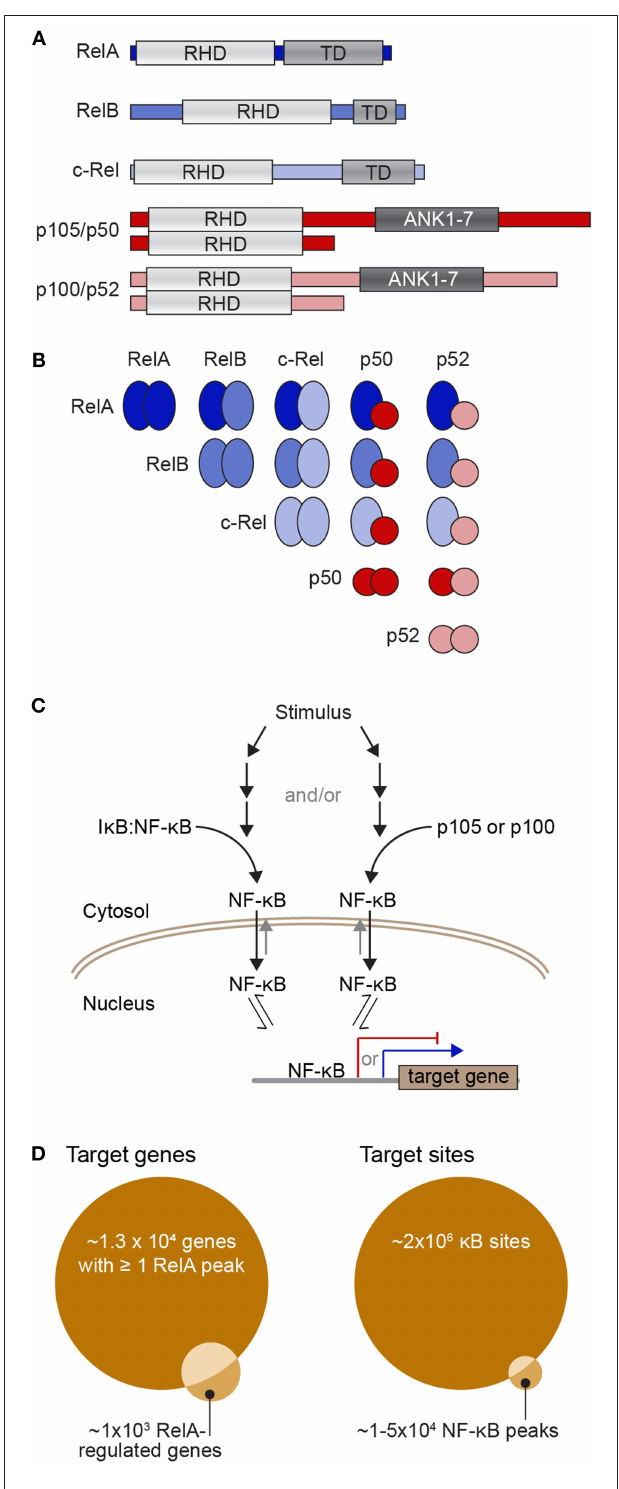
FIGURE 1 | The NF- κ B transcription factor family and its dimerization and DNA interactions. (A) Diagrams of the five NF- κ B subunits showing their Rel homology domain (RHD), which encompasses both their DNA-binding